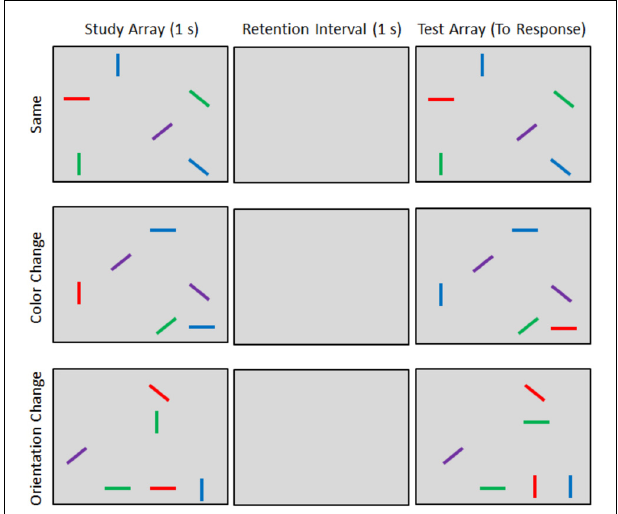
FIGURE 1 | Example stimuli and trials types. Participants indicated whether the study and test arrays were the same or different. Participants completed two blocks of 160 trials each. Within each block, 80 same trials, 40 color-change trials, and 40 ori- entation change trials were randomly intermixed. Across blocks, hand position was manipulated. In the hands-far block, partic- ipants placed their hands on the table top in front of them. In